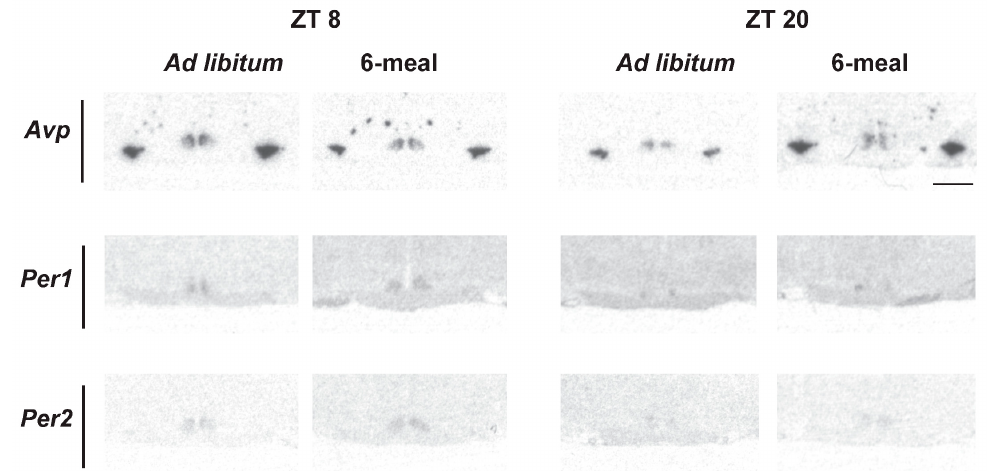
Figure 3. Representative photomicrographs of AVP, Per1 and Per2 expression in the SCN of ad libitum and 6 ‐ meals ‐ a ‐ day animals at ZT 8 and 20. (Scale bar 1 mm).